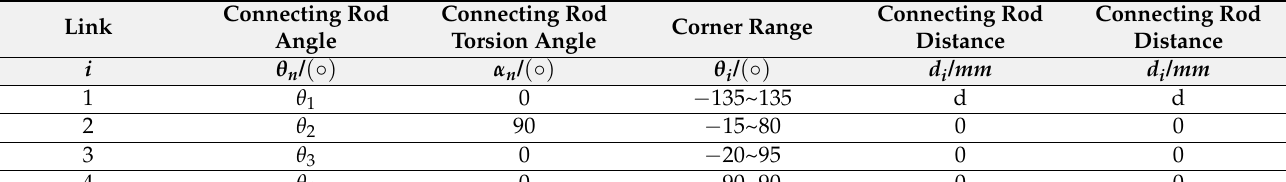
Table 3. Parameters of the experimental manipulator connecting rod.